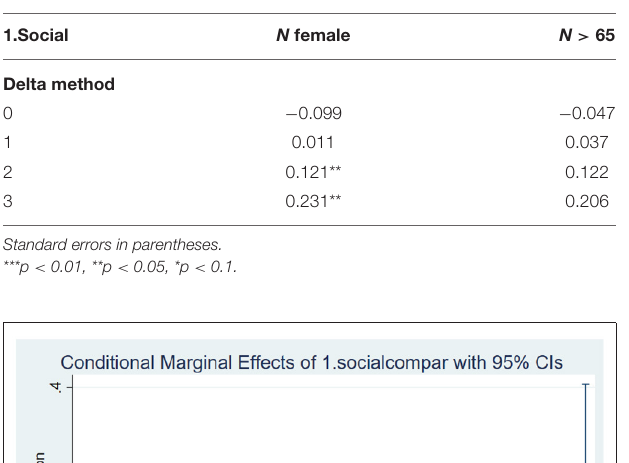
TABLE 6 | Conditional marginal effects of household characteristics.